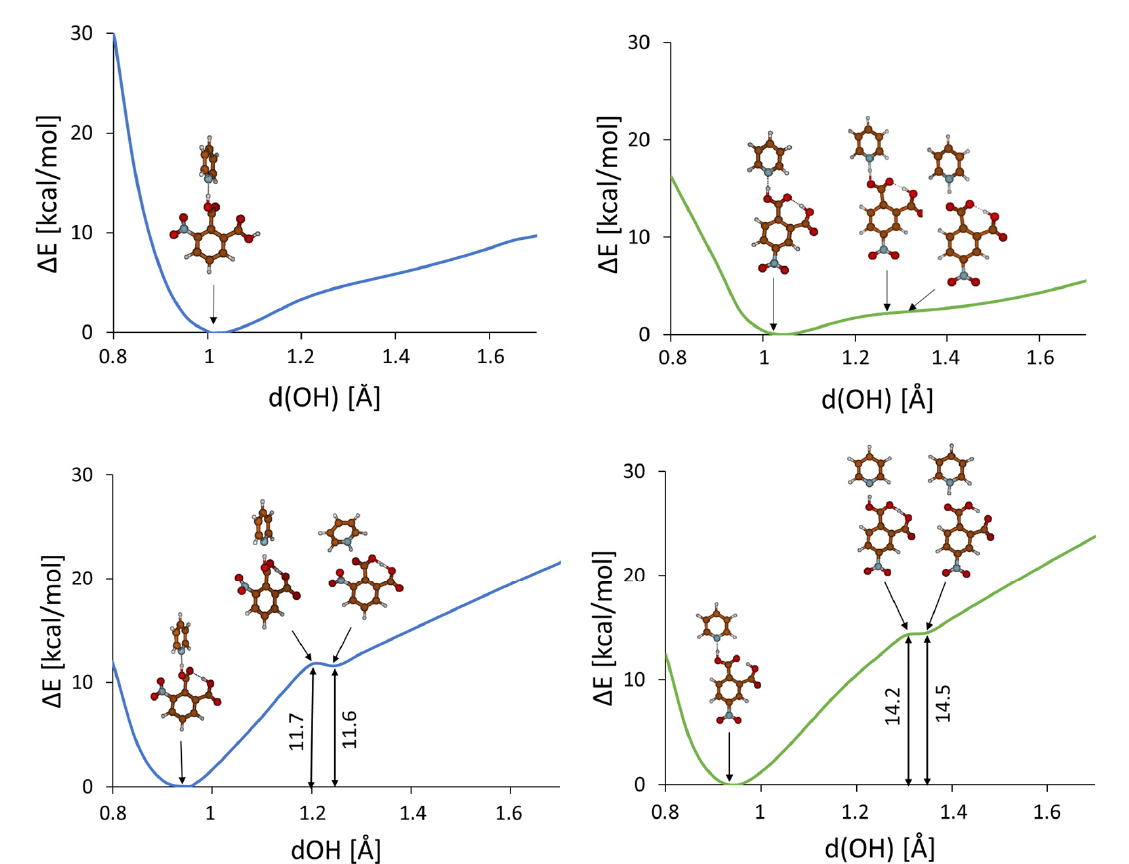
Figure 3. Calculated (B3LYP-D3/6-311+G(d,p)) potential energy curves for a gradual elongation of one proton within the intermolecular (upper panel) and intramolecular hydrogen bonds (bottom panel) in 3NFA-P (left side, blue line) and 4NFA-P (right side, green line) complexes of nitro-phthalic acids with pyridine.